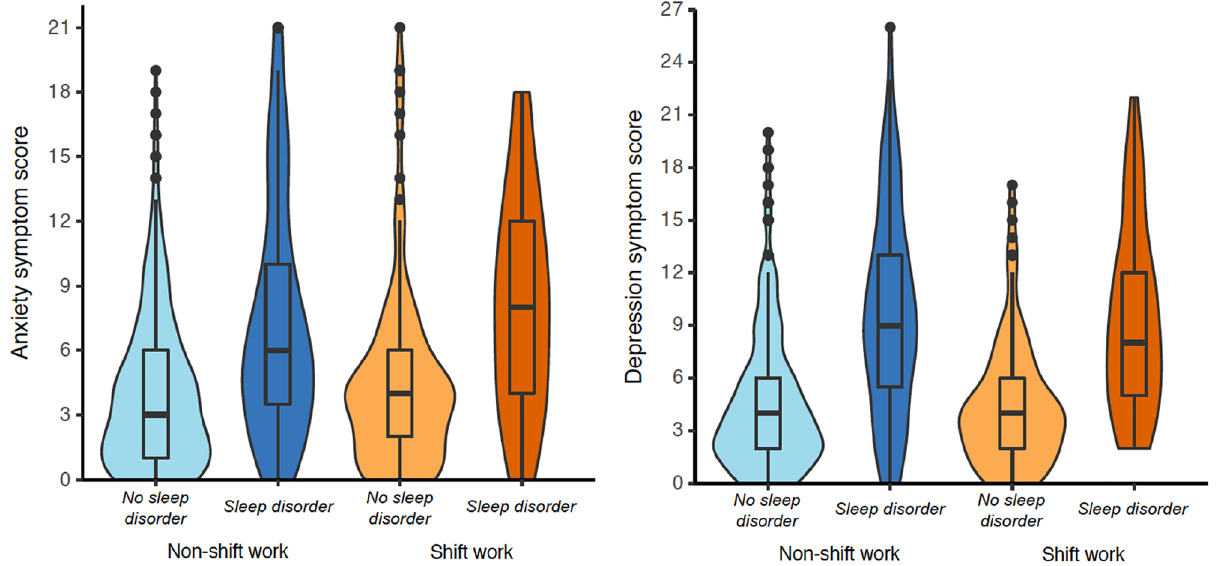
Figure 2. Anxiety symptom score (left) and depression symptom score (right) by shift work and sleep disorder status . Violin plots reflect the density (width) and range (height) of scores within each category of work type and sleep disorder status. Inset boxplots depict the median and interquartile ranges. Black dots reflect outlier values. Anxiety is measured with the GAD-7 (range from 0–21), and depression is measured with the PHQ-9 (range from